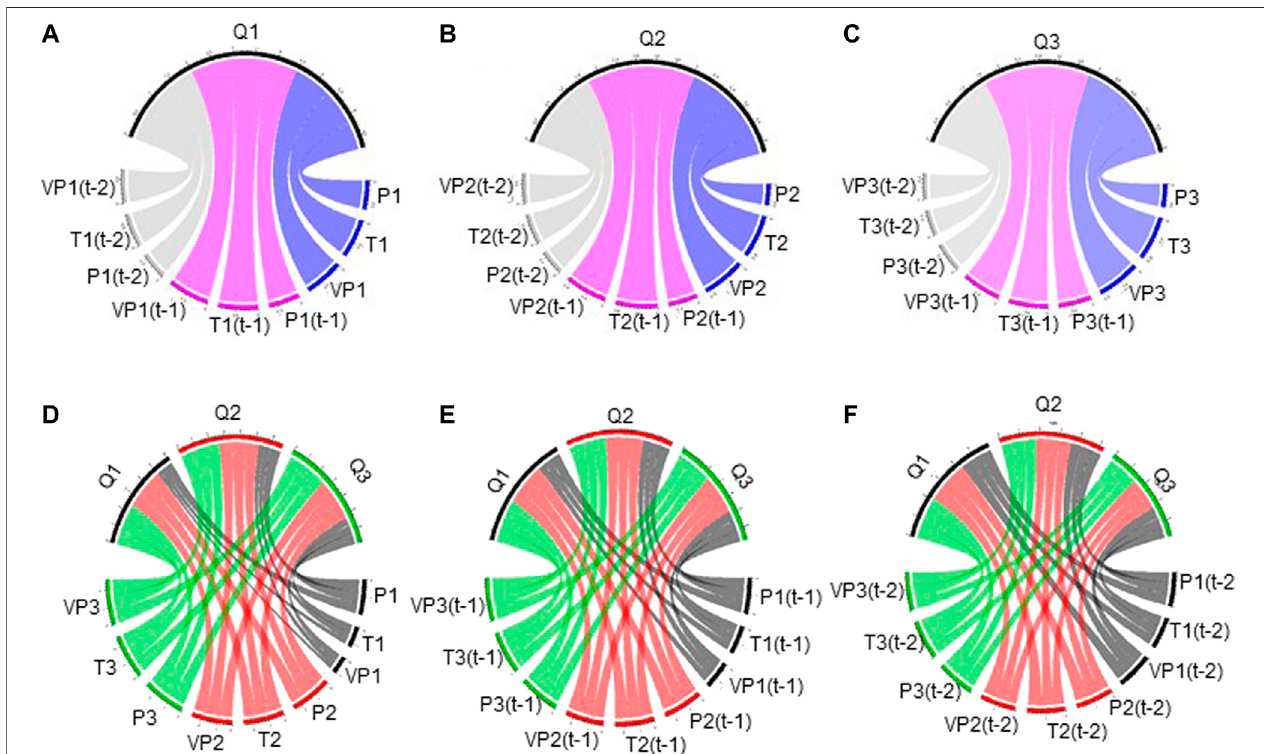
FIGURE 3 | The correlation between predictors and stream fl ow. stream fl ow.[Note: (A) , (B) , and (C) present the correlation between predictors in different month ahead and stream. (D – F) present the correlation between predictors and streams between different stations. Predictors are de fi ned in Table 2 ].